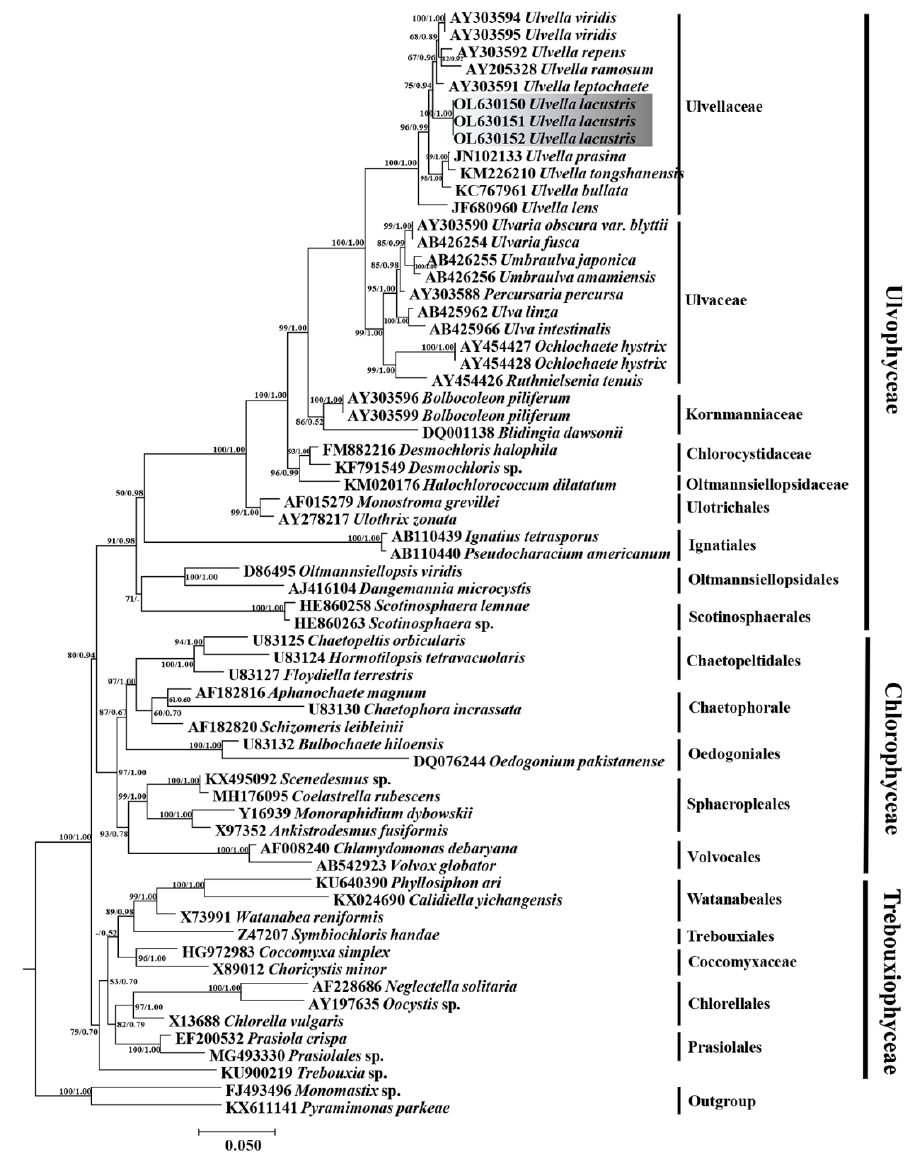
Figure 4. Maximum likelihood phylogenetic tree of Chlorophyta based on 18S rDNA sequences. Maximum likelihood bootstrap values and Bayesian posterior probabilities are given on nodes. Values above 0.50 for BI and 50 for ML are given. The new species in this study are shaded in gray.